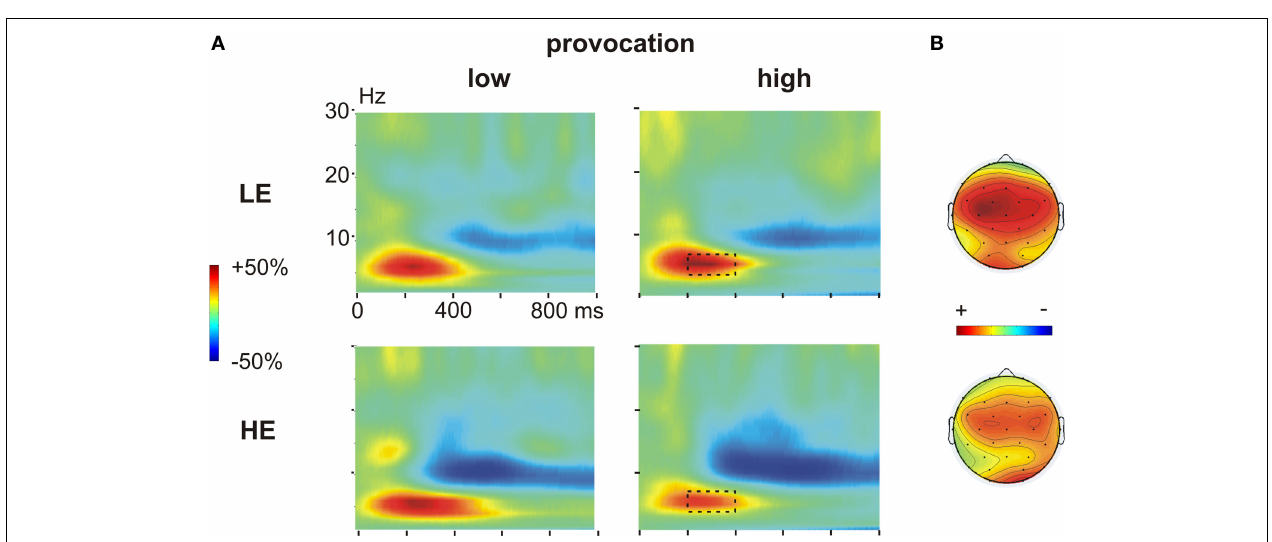
frequency (4–7 Hz) and time range (200–400 ms), which was analyzed for the theta effect. (B) Topography of the theta increase under high provocation in the LE (upper map) and HE (lower map) group. The scaling of the maps is − 20 to 40% of power change. Note the higher theta power increase in the LE compared to the HE